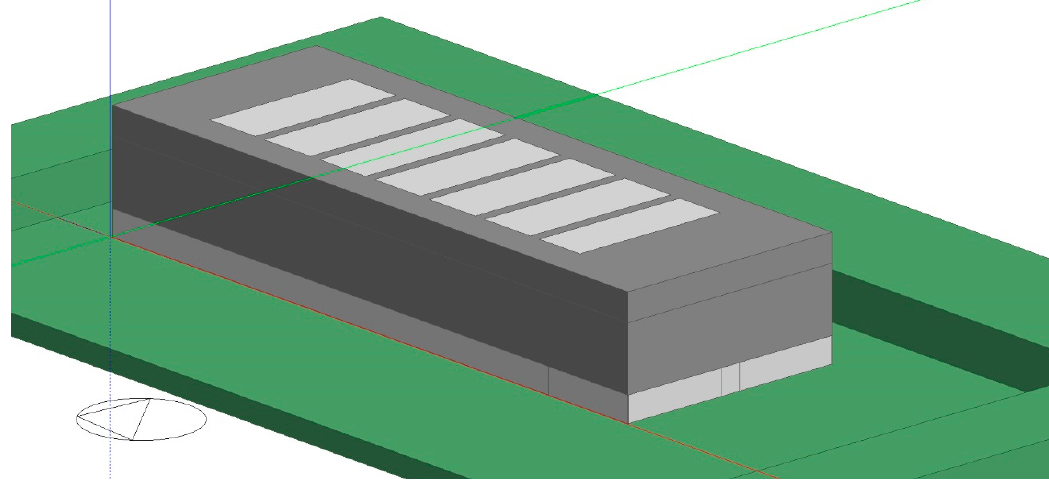
Figure 8. Model of the MUA in Design Builder.